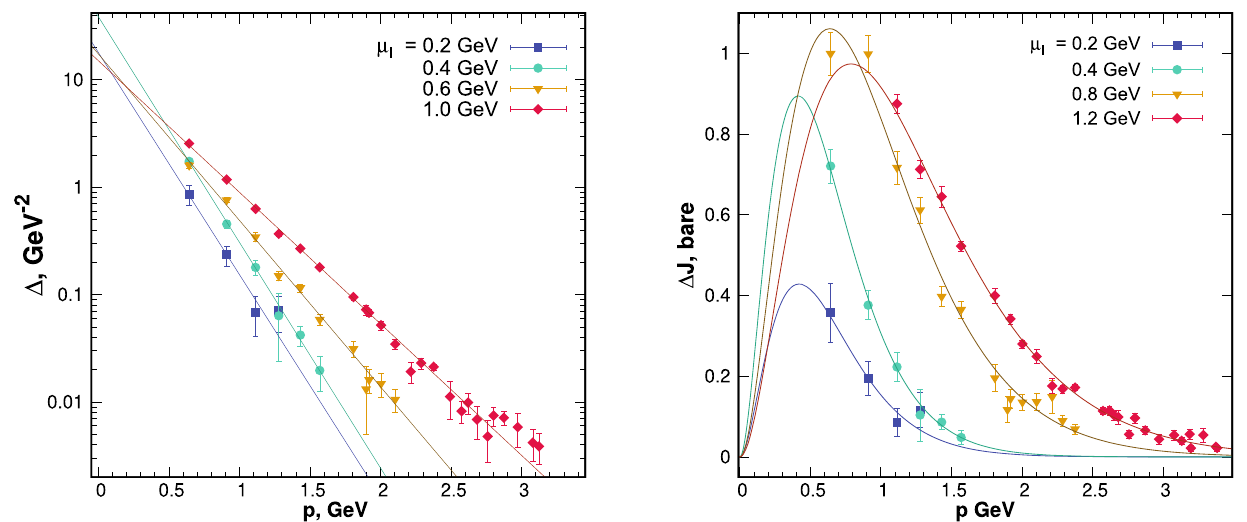
Fig. 8 The difference between the propagators D T − D L (left) and dressing functions J T − J L (right) as a function of the momentum. The curves show results of the fit to (27) μ I is very similar to dependence on the temperature, see